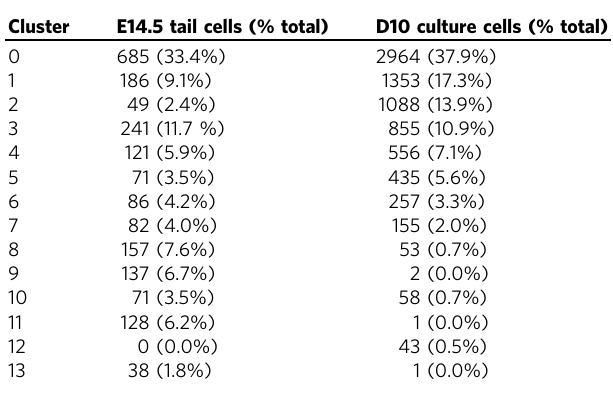
Table 1 Percent contribution of E14.5 tail cells and D10 mESC-derived culture cells to each scRNA-seq cluster.